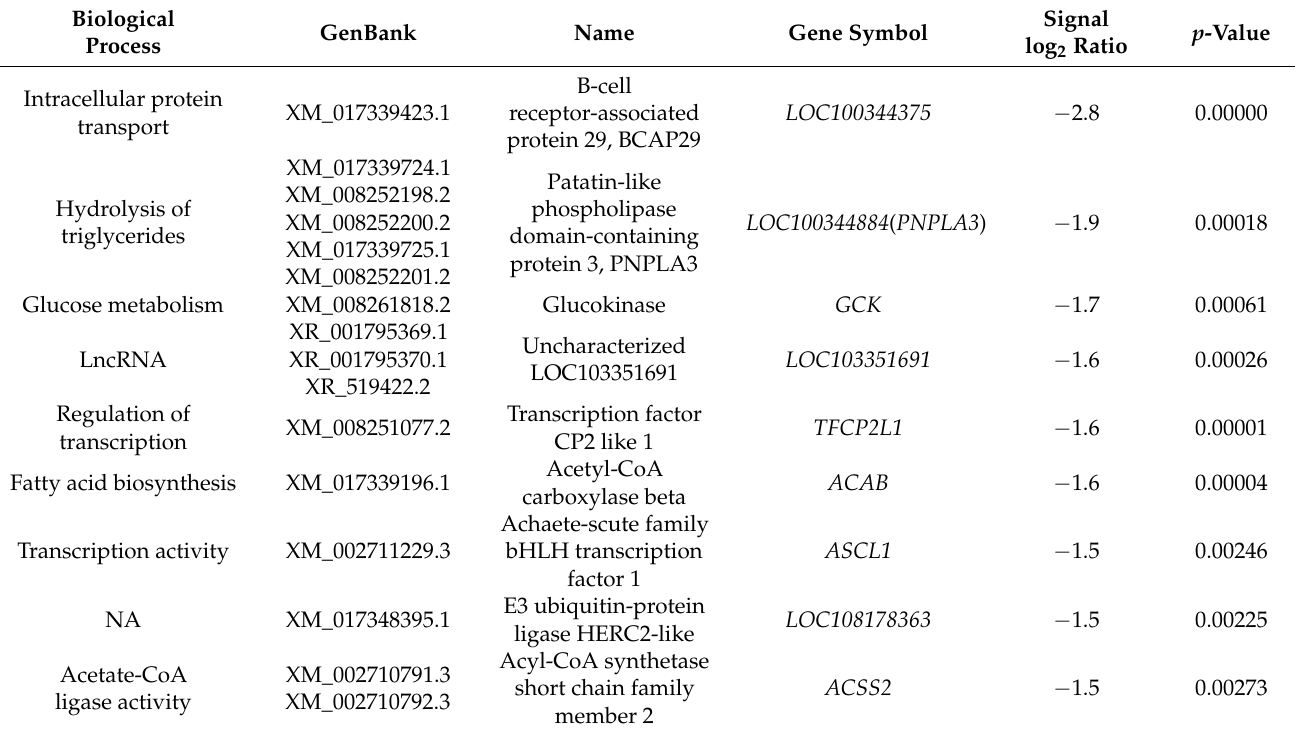
Table 1. Hepatic transcripts differentially downregulated by the administration of squalene at the level of signal log 2 ratio < 1.5 and false discovery rate < 0.001 in male Oryctolagus cuniculus according to RNAseq.